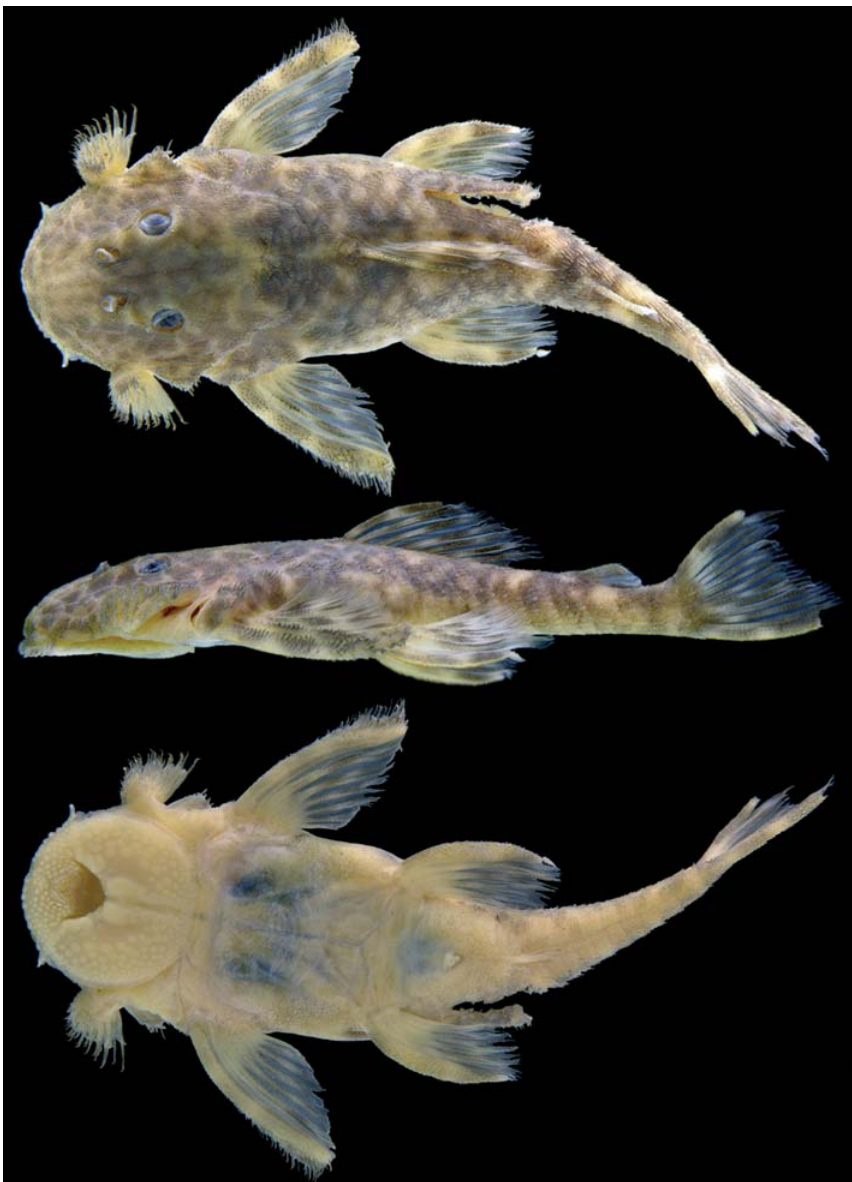
Fig. 1. Lithoxus jantjae , holotype, MCNG 55349, 38.4 mm SL, Venezuela, Amazonas State, Ventuari River upstream of Tencua